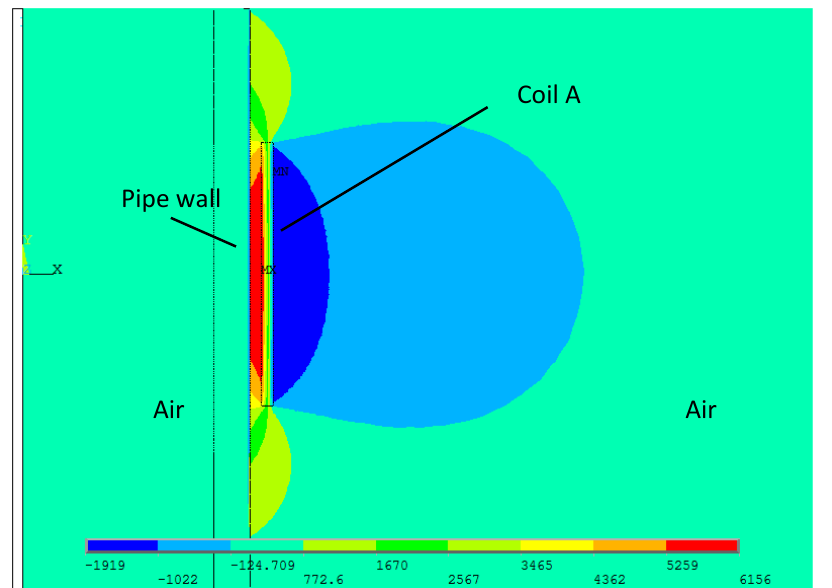
) produced by two transmitter coils with z